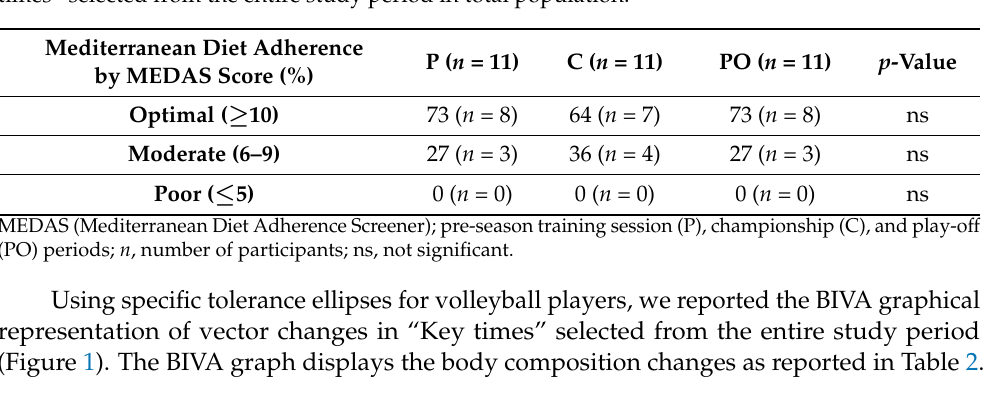
Table 3. Percentage of MEDAS (Mediterranean Diet Adherence Screener) score referring to “Key times” selected from the entire study period in total